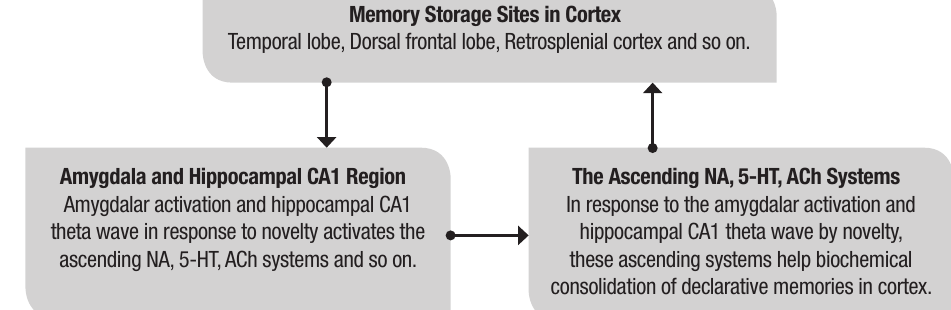
Figure 1. The processes of limbic-reticular coupling theory for memory consolidation.